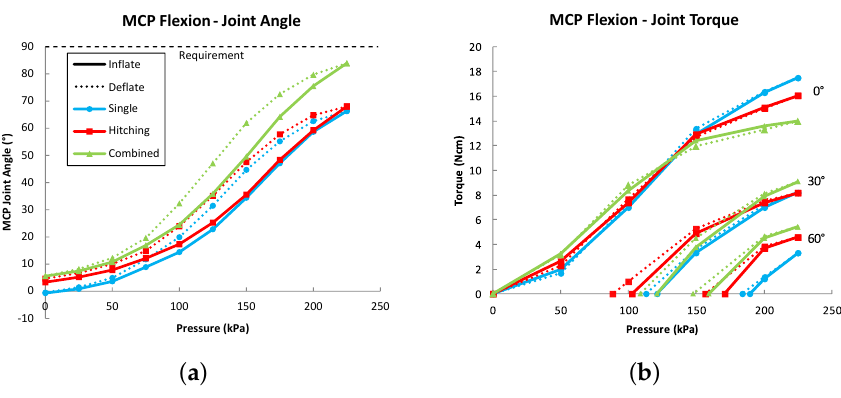
Figure 7. MCP joint flexion measurement results for ( a ) joint angle and ( b )